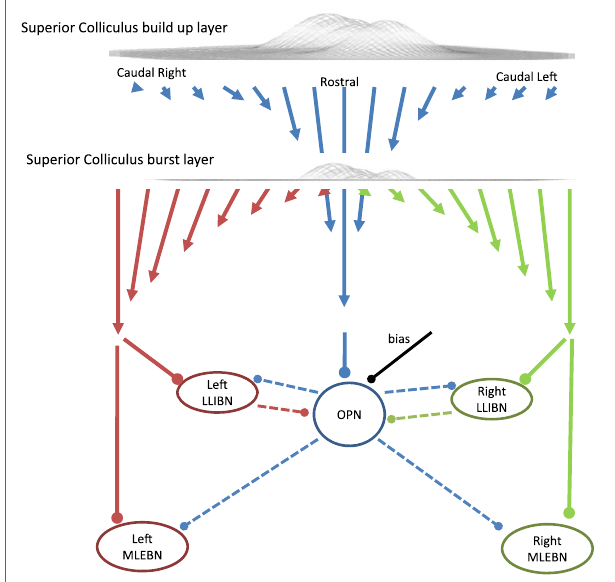
FigUre 4 | Schematic of the projections from the superior colliculus (SC) to the reticular formation and the triggering circuit. In this model, the SC is a one-dimensional structure with 101 interconnected neurons. During fixation, the activity centers around the middle (which corresponds with the rostral area). The omnipause neuron (OPN) receives excitatory inputs from the buildup layer of the SC with stronger connections (represented as longer arrows) from the more rostral areas. The OPN inhibits all burst neurons (BNs) in the model. The BNs receive excitatory inputs from the contralateral burst layer of the SC with stronger connections from the more caudal areas so the total average input is proportional to the eccentricity of the center of mass of the SC activity. Arrows represent excitatory connections and dots represent inhibitory